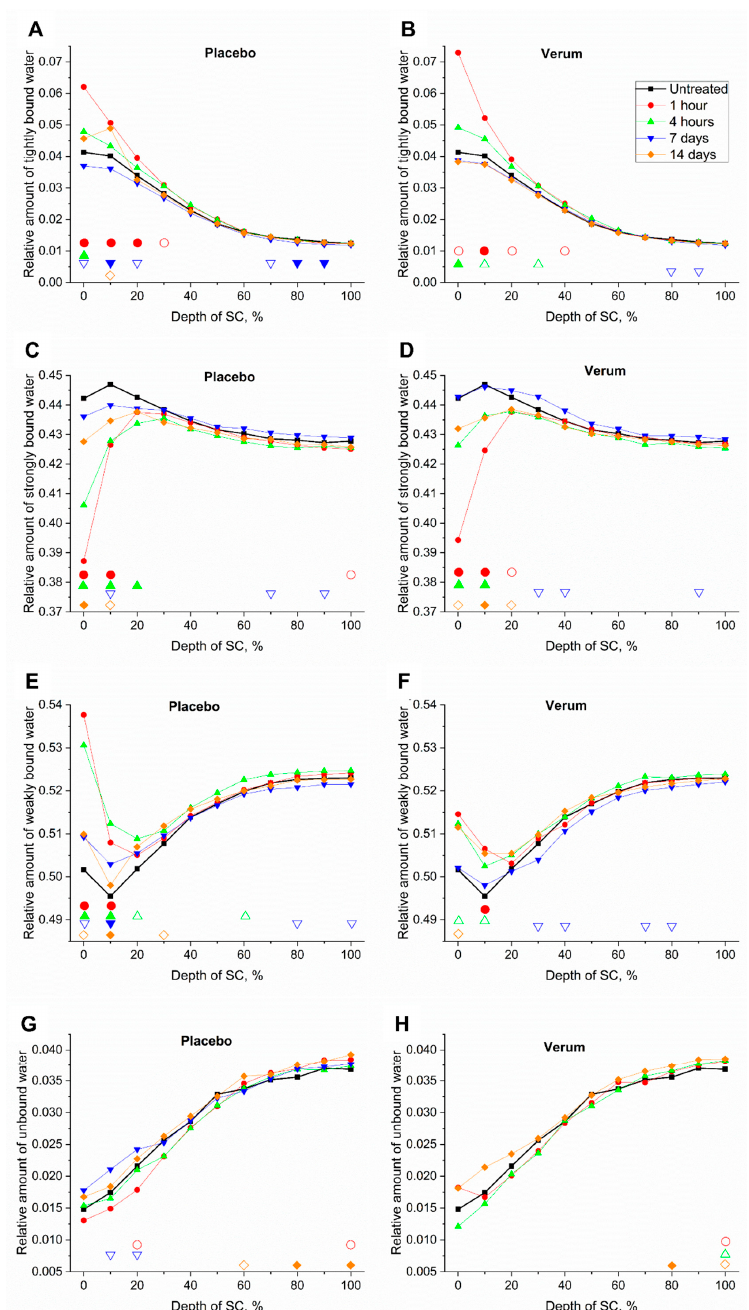
Figure 5. Relative mean amount of tightly bound—( A , B ), strongly bound—( C , D ), weakly bound— ( E , F ) and unbound water ( G , H ) of all subjects before (untreated, black squares) and 1 h (red circles), 4 h (green upward triangles), 7 days (blue downward triangles) and 14 days (orange diamonds) after beginning of the treatment with the placebo ( A , C , E , G ) and verum ( B , D , F , H ). The signals are normalized to the thickness of the SC (0–100%). Significant differences ( p < 0.05) are marked below in empty shapes, strongly significant differences ( p < 0.01) in solid